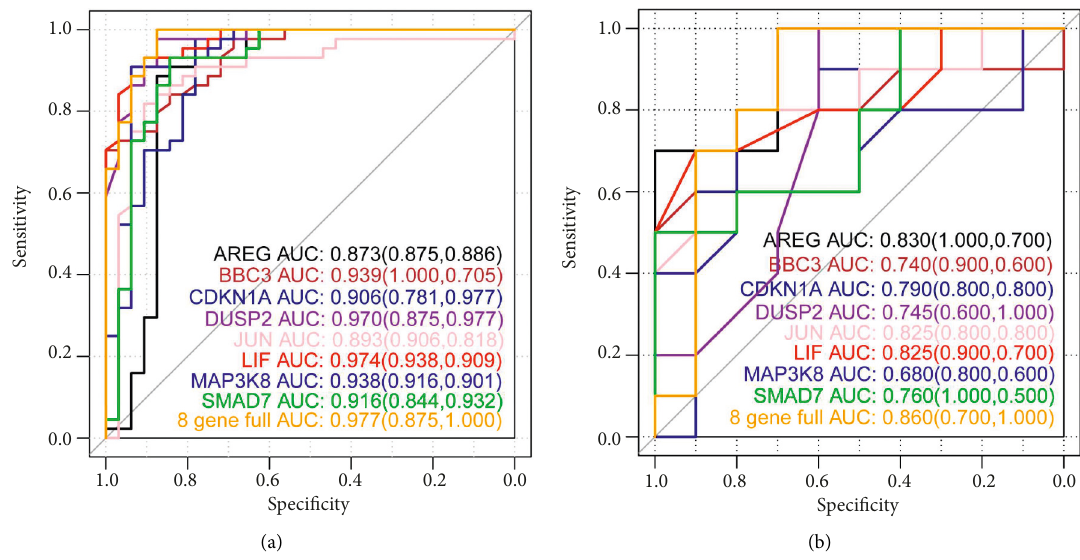
Figure 9: After the classifier is trained and the ROC curve is constructed, as shown in Figure 9.